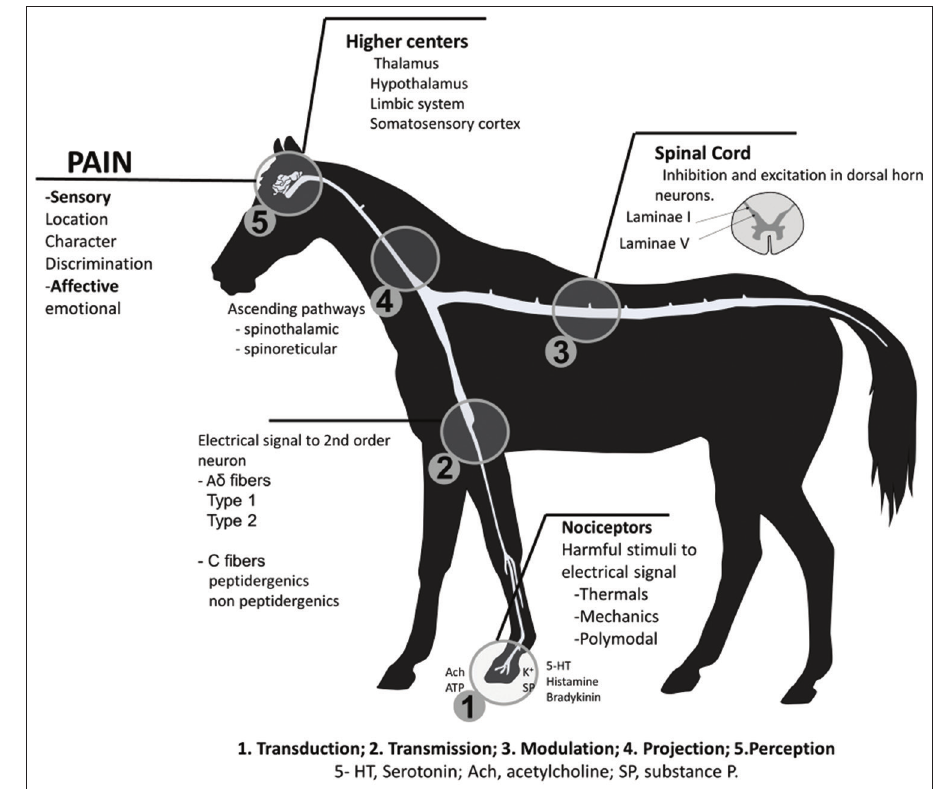
Figure-1: Neurophysiological pathway of nociceptive pain